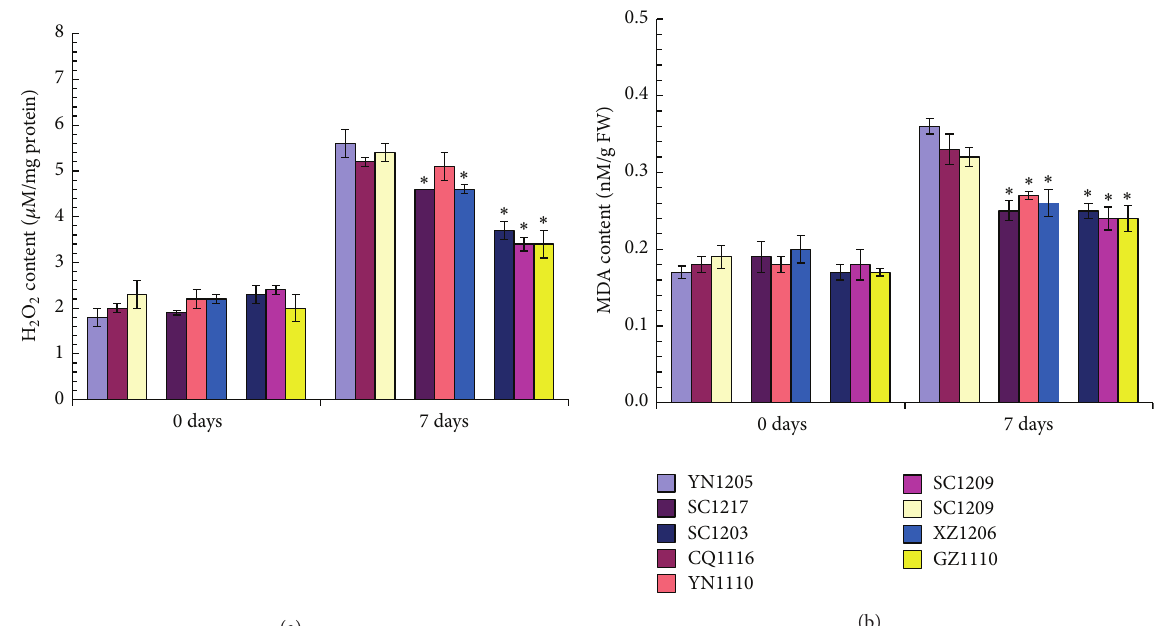
Figure 5: Comparison of ROS levels reflected by H 2 O 2 (a) and MDA (b) contents in leaves from nine selected C. dactylon accessions in response to SO 2 stress. Mean values are presented with vertical error bars representing the standard deviations ( 𝑛 = 3 ). The asterisk symbols indicate significant differences between SO 2 -sensitive accessions and SO 2 -tolerant